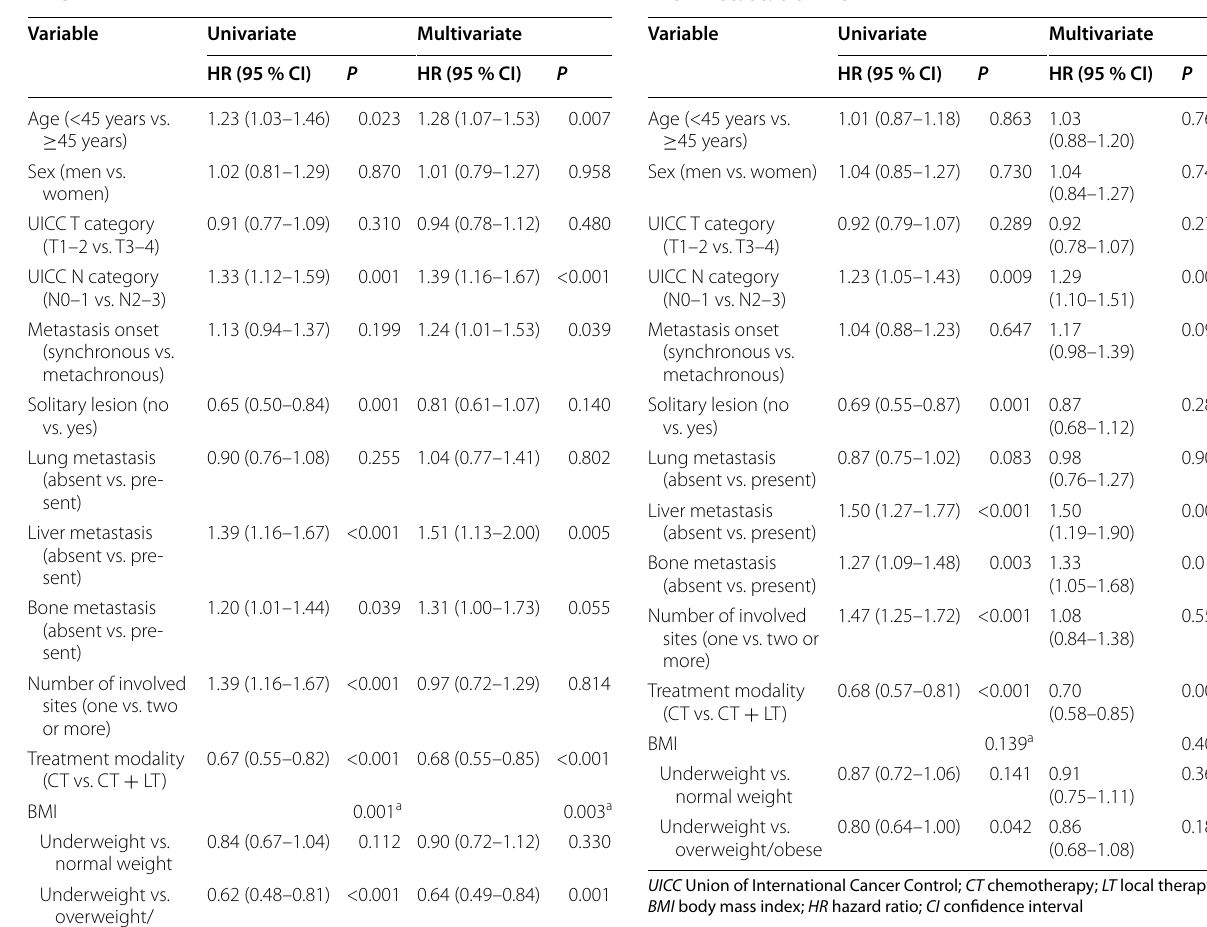
Table 2 Univariate and multivariate analyses of covariates associated with overall survival in patients with metastatic